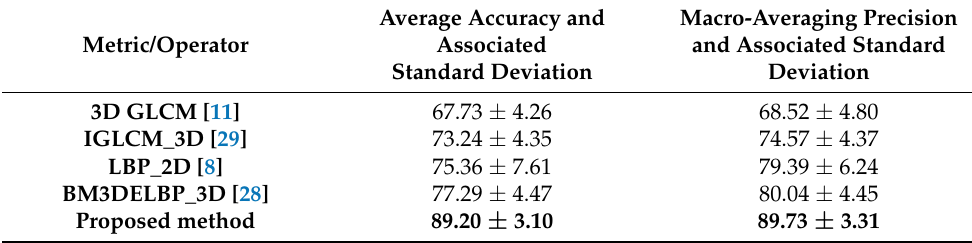
Table 5. Classification results for the first experiment with the kNN classifier [%].